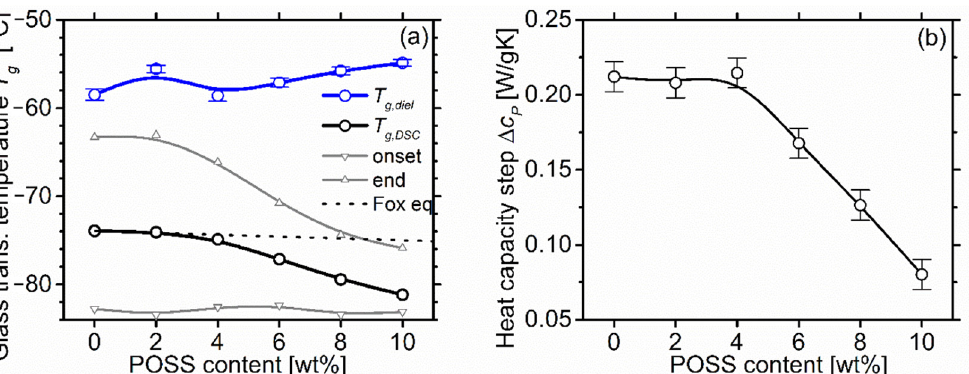
Figure 6. ( a ) Glass transition temperature as measured by two techniques (Dielectric Relaxation Spectroscopy, DRS, to be discussed in Section 2.5). The onset and endpoints of the glass transition step in DSC are plotted as grey lines. The dotted line corresponds to the estimation of T g according to Fox equation, taking into account that T g of POSS is − 84 ◦ C [32]. ( b ) Heat capacity change at midpoint as a function of POSS content. Lines are guides to the eye.